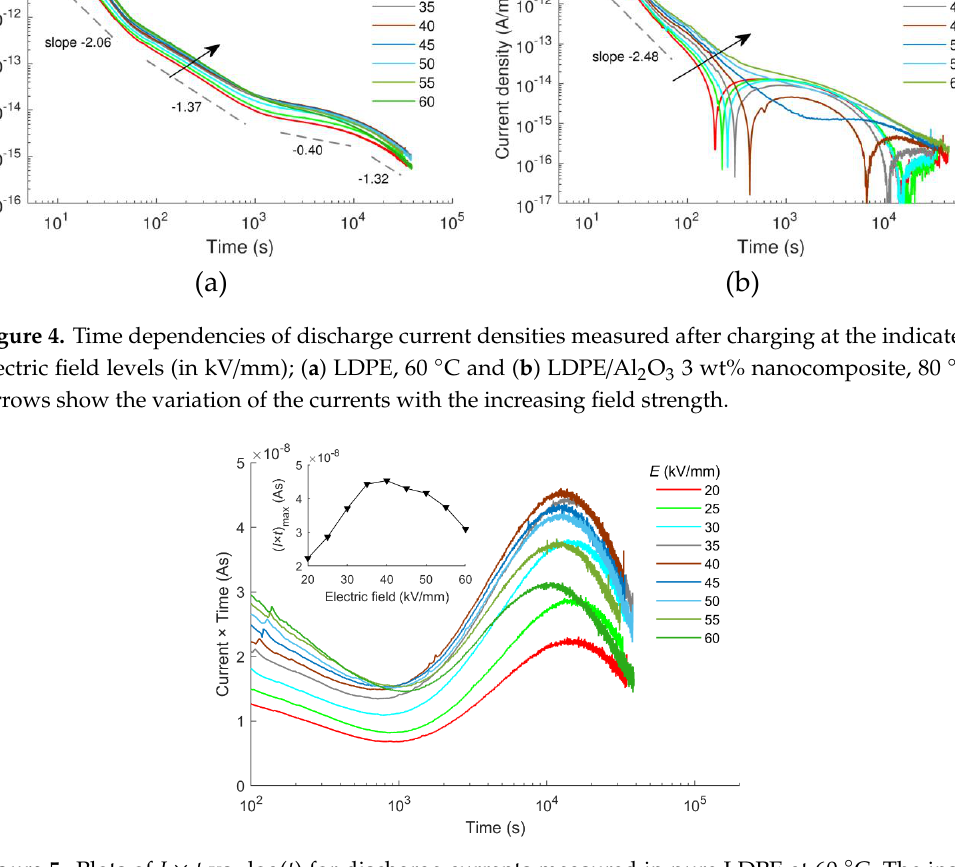
Figure 5. Plots of I × t vs. log( t ) for discharge currents measured in pure LDPE at 60 °C. The inset shows the field dependence of the peak values I × t .